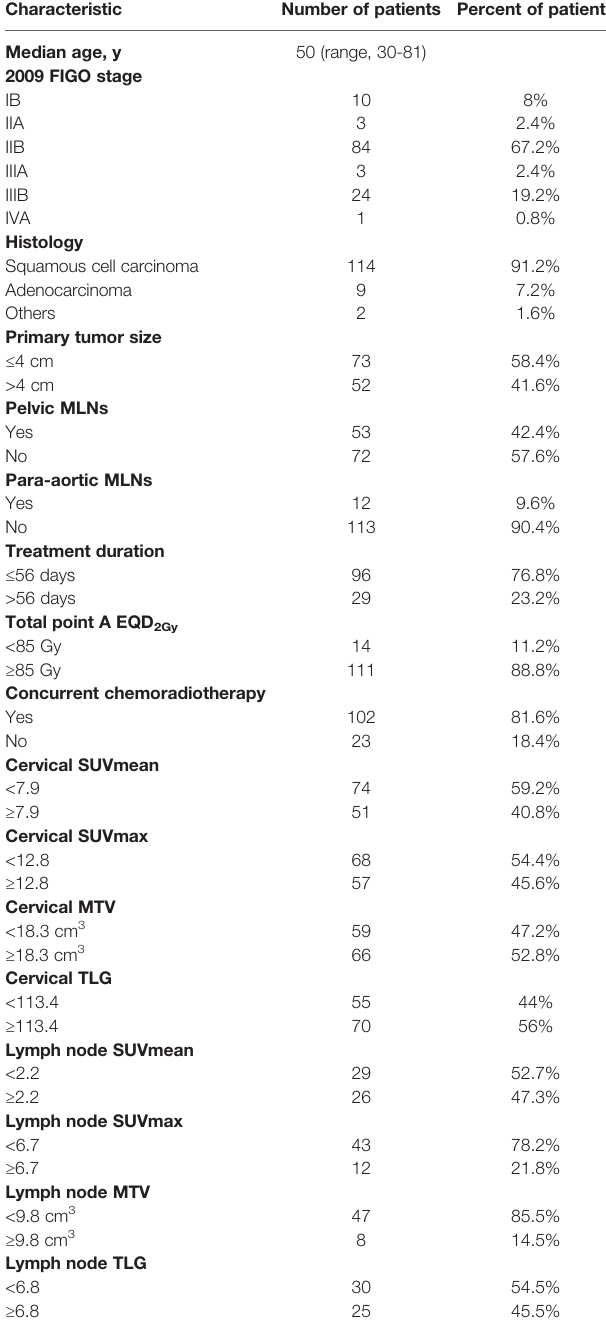
FIGO, International Federation of Gynecology and Obstetrics; MLN, metastatic lymph node; EQD 2Gy , equivalent dose at 2 Gy; SUV, standardized uptake value; MTV, metabolic tumor volume; TLG, total lesion SUVmax, LN TLG and LN MTV were 2.2, 6.7, 6.8 and 9.8 cm 3 , respectively.